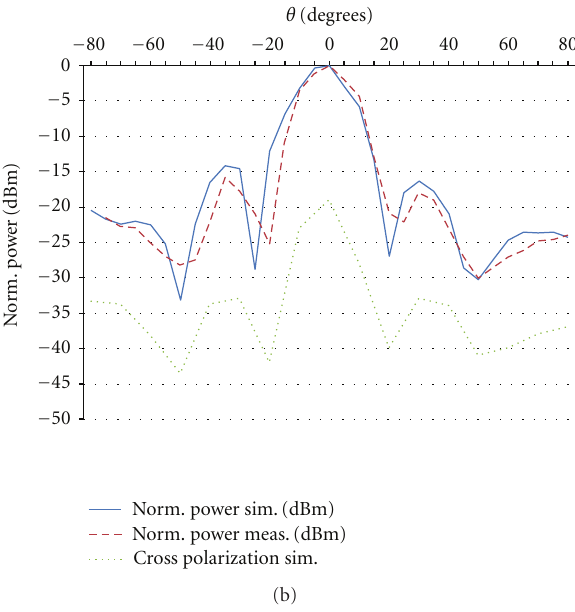
Figure 7: (a) Radiation pattern of backhaul antenna in yz plane for 3.5GHz. (b) Radiation pattern of backhaul antenna in xz plane for